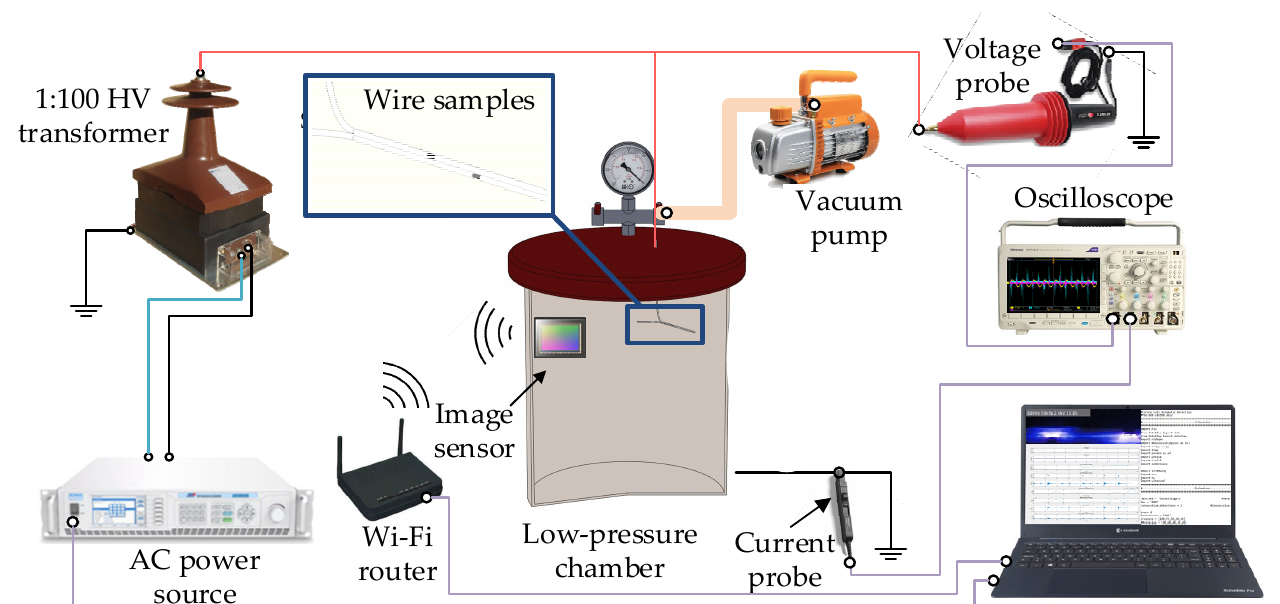
Figure 5. Sketch of the experimental setup.